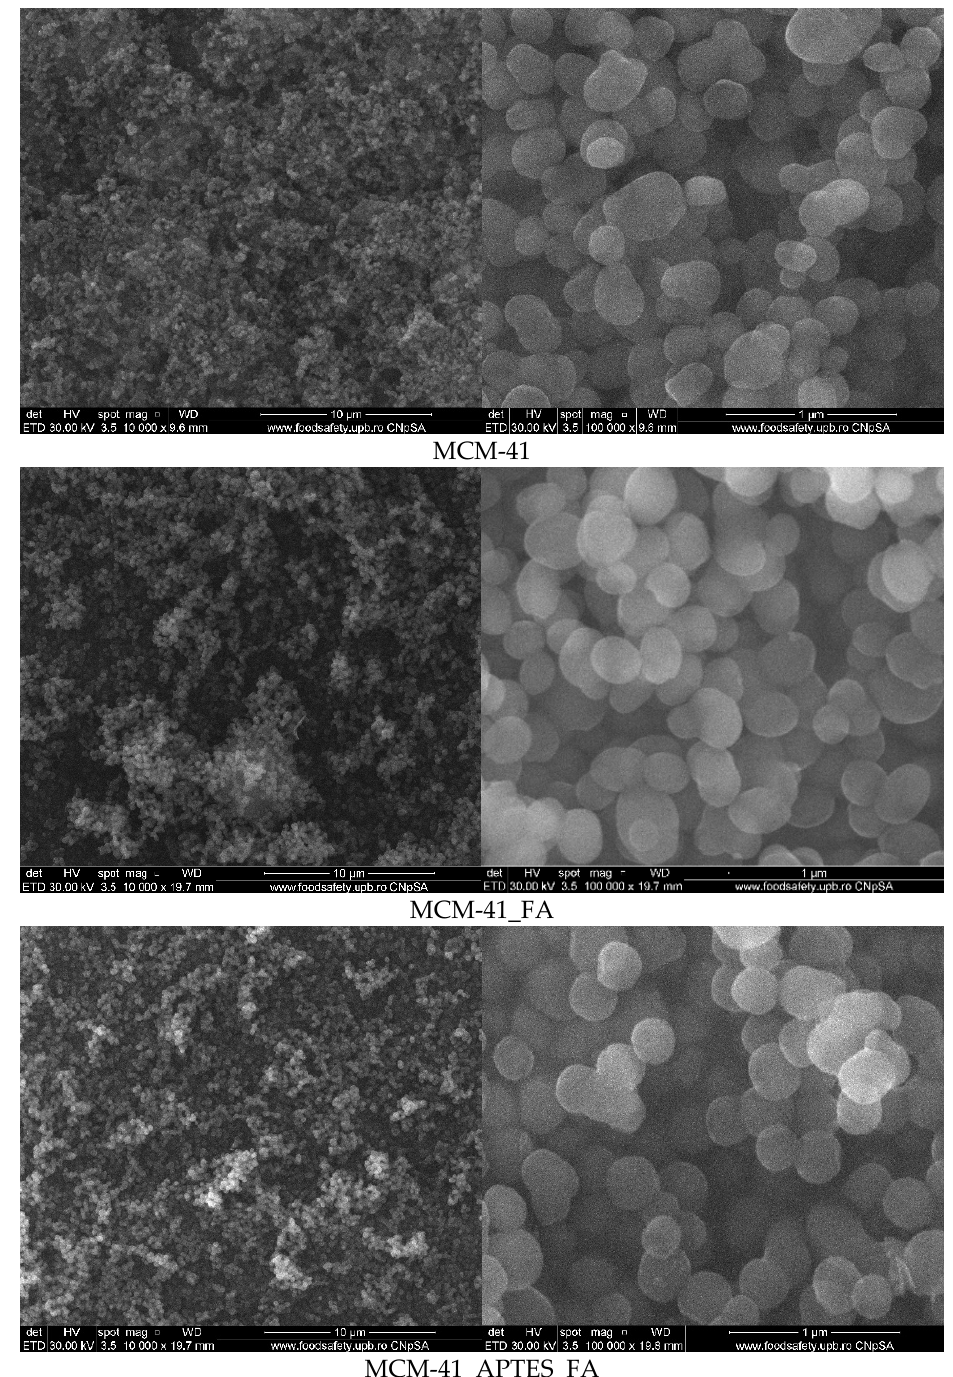
Figure 6. SEM micrographs for mesoporous materials based on MCM-41 support. SEM micrographs (Figure 7) recorded for the mesoporous materials based on MCM-48 indicate the presence of quasi-spherical silica particles with sizes in the 150–400 nm interval. In addition, similarly to MCM-41 based samples, we can consider that FA is mainly loaded inside the pores.